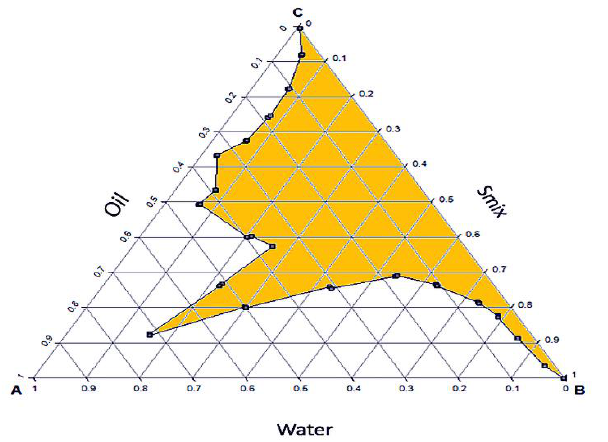
Figure 3. Pseudo-ternary Phase diagram of optimized nano-emulsion with corn oil, Smix (tween 20 + lecithin; 2:1) and water.